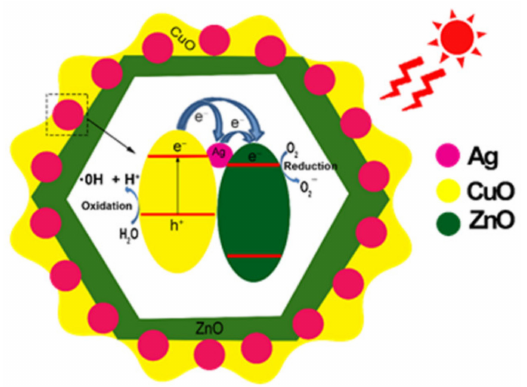
Figure 7. A schematic band diagram for electron transfer between the conduction band of CuO, ZnO, and the Ag Fermi